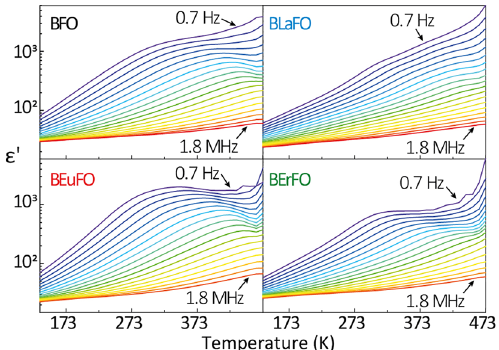
Figure 4. Temperature and frequency dependence of the real part of dielectric permittivity of BFO, BLaFO, BEuFO, and BErFO